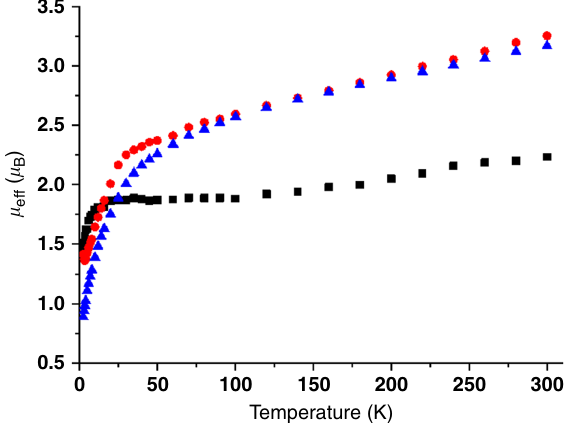
Fig. 2 Variable-temperature SQUID magnetic moment data for 3, 6, and 8. Key: 3 (black squares), 6 (red circles), and 8 (blue triangles). Data were measured in an applied magnetic fi eld of